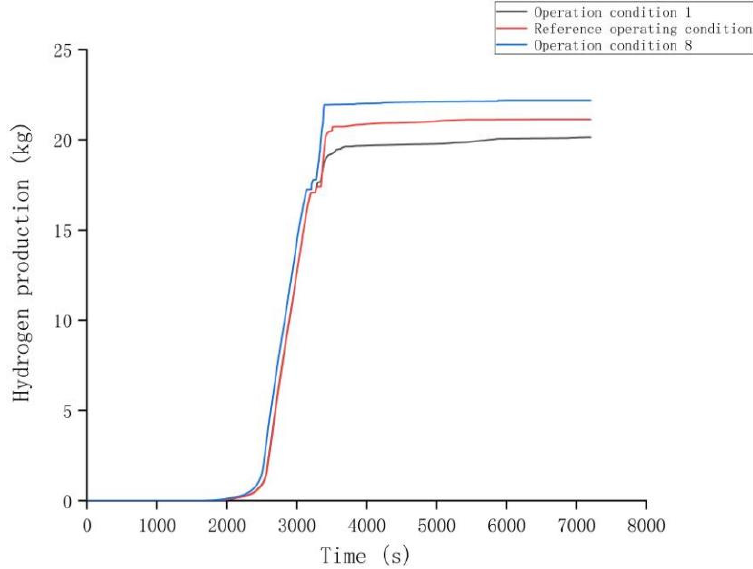
Figure 9. Scatter diagram of hydrogen production in 38 mm LOCA.